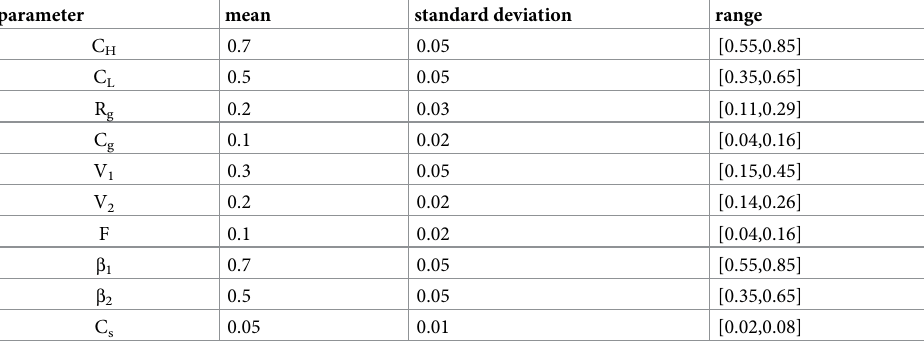
Table 3. Parameters and the corresponding values used in sensitivity test.